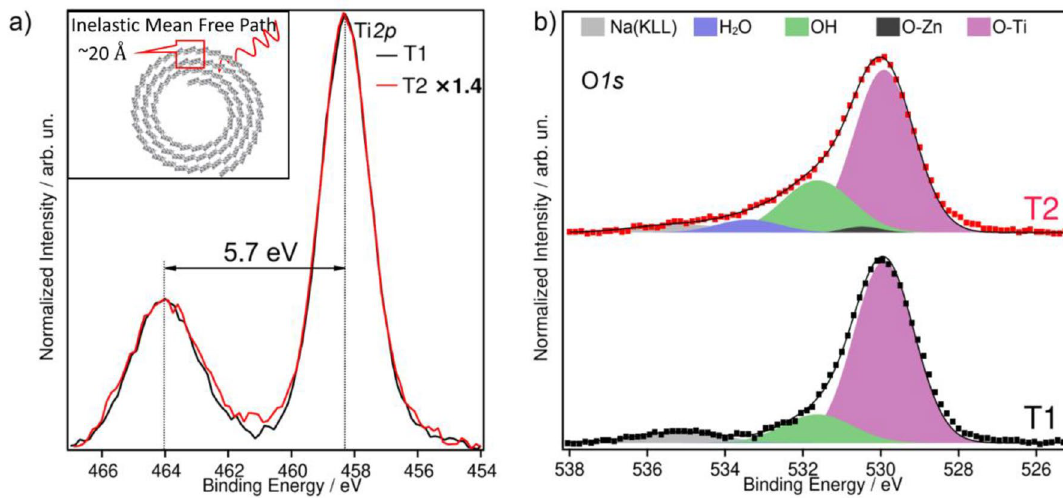
Figure 7. XPS spectra of the Ti2p ( a ) and O1s regions ( b ) for the samples T1 and